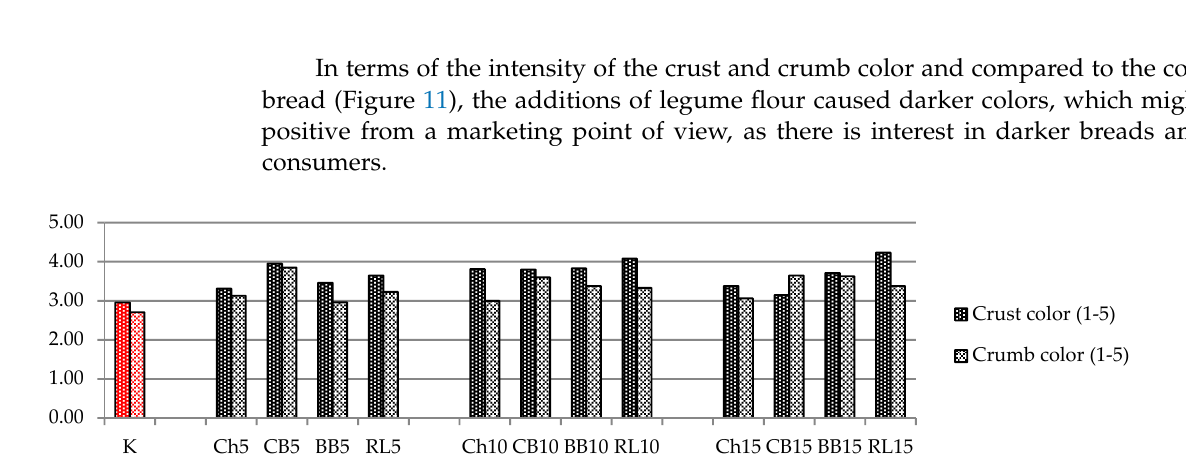
Figure 11. Intensity of the crust and crumb color rated by a 5-point system, 1 = least intensive color, 5 = most intensive color. K = WF(50) + RF(50); Ch5 = WF(50) + RF(45) + ChF(5); Ch10 = WF(50) + RF(40) + ChF(10); Ch15 = WF(50) + RF(35) + ChF(15); CB5 = WF(50) + RF(45) + CBF(5); CB10 = WF(50) + RF(40) + CBF(10); CB15 = WF(50) + RF(35) + CBF(15); BB5 = WF(50) + RF(45) + BBF(5); BB10 = WF(50) + RF(40) + BBF(10); BB15 = WF(50) + RF(35) + BBF(15); RL5 = WF(50) + RF(45) + RLF(5); RL10 = WF(50) + RF(40) + RLF(10); RL15 = WF(50) + RF(35) + RLF(15).